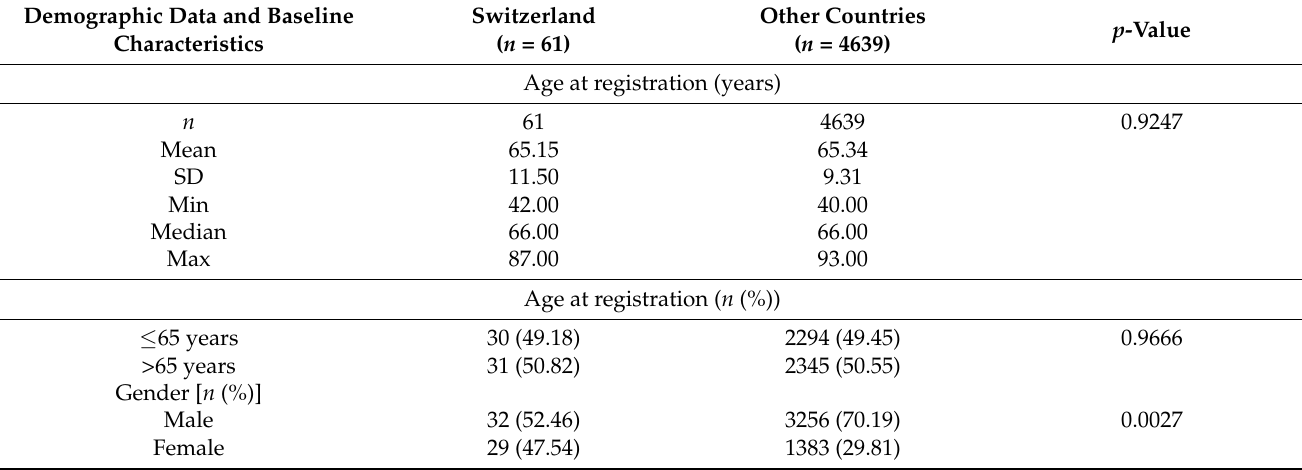
Table 1. Demographic data and baseline characteristics of the Swiss cohort and the other countries. Demographic Data and Baseline